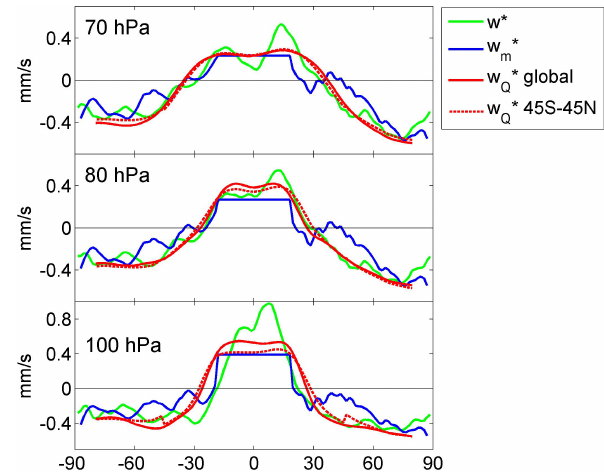
Fig. 2. Latitudinal structure of the three upwelling estimates at the indicated pressure levels (70, 80 and 100hPa from top to bottom). Green: residual circulation ( w ∗ ) blue: momentum balance estimate ( w ∗ m ), and red: thermodynamic estimate ( w ∗ ). Two red lines are Q shown: the solid line is the thermodynamic upwelling estimate com- puted with the global adjustment and the dashed line adjusting only within the range 45 ◦ N–S (see text for details) (mms − 1